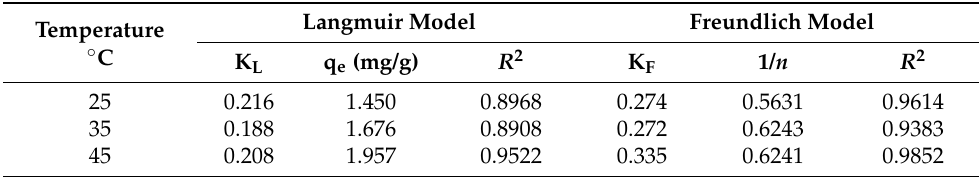
Figure 14. Fitting of the fluoride adsorption process with the Langmuir isotherm model ( a ) and the Freundlich isotherm model ( b ). Table 8. Parameters of the adsorption isotherm models.